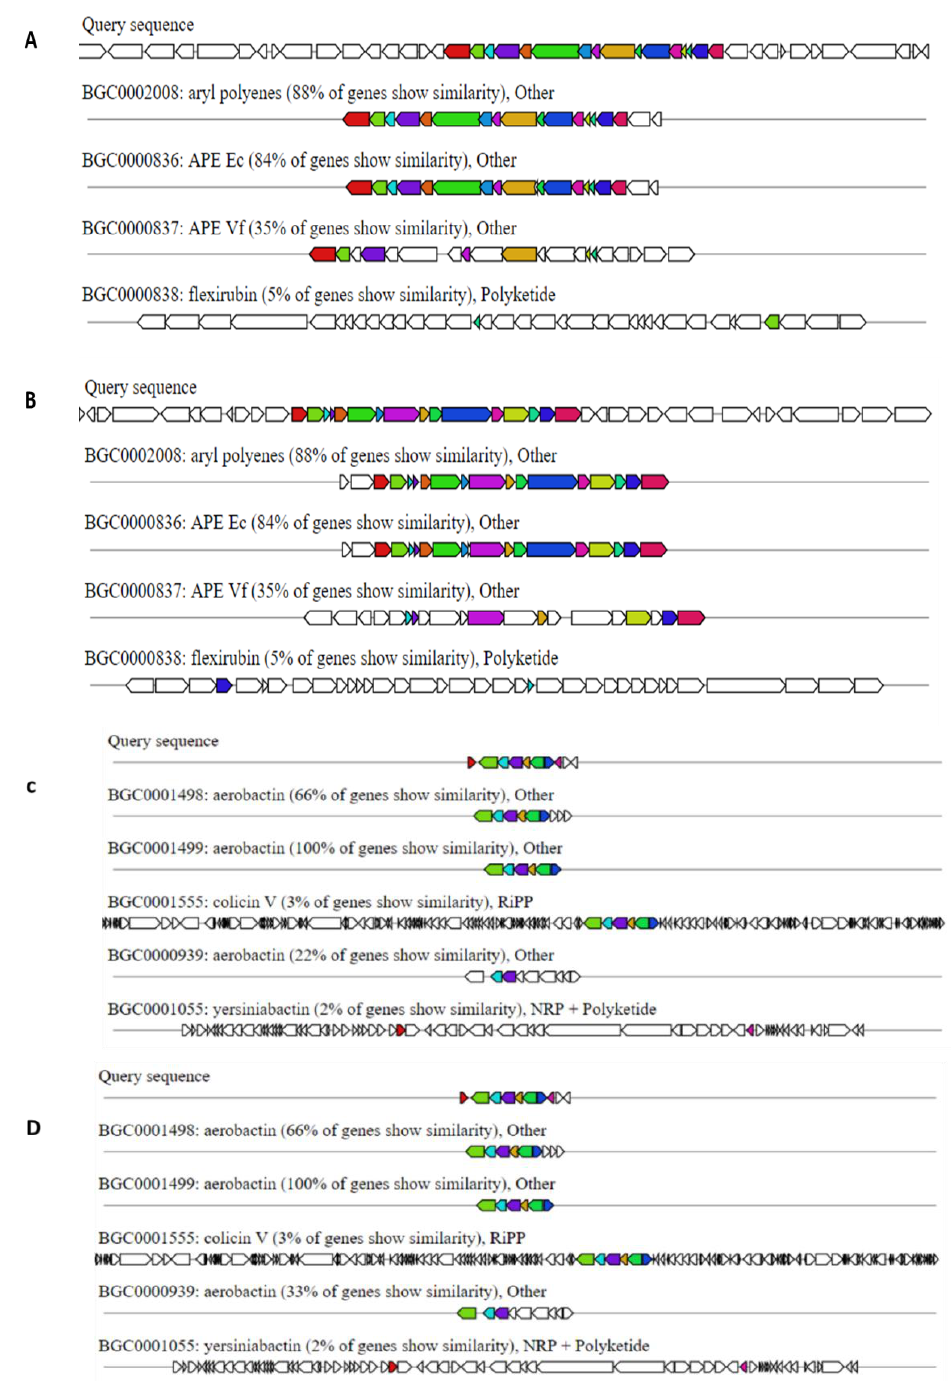
Figure 2. Biosynthetic gene clusters (BGCs) detected in the genome sequences of isolates S4 and S5. ( A , B ) Aryl polynes (APEs) for genomes S4 and S5, respectively. ( C , D ) Aerobactin for genomes S4 and S5, respectively. Query sequences are the genome sequences of the isolates S4 and S5.